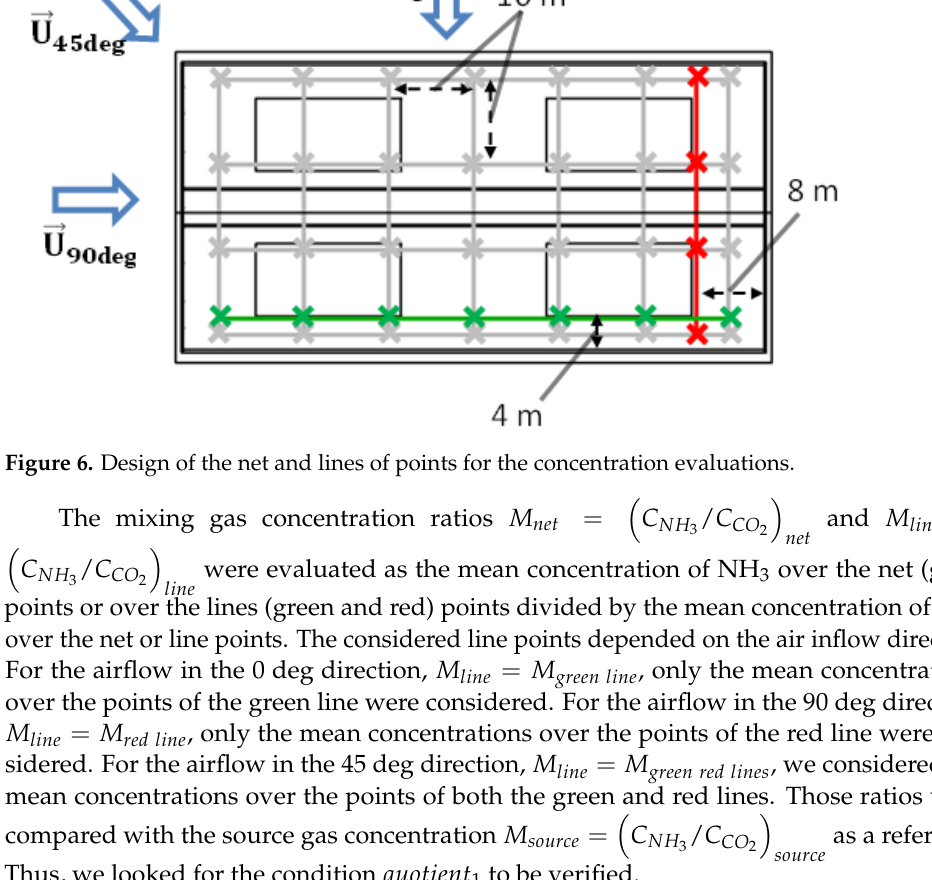
(cid:16) (cid:17) C NH / C CO and M line = 3 2 net (cid:16) (cid:17) C NH / C CO as a reference. 3 2 source